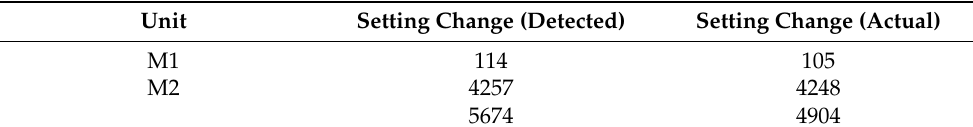
Table 7. Performances of the clustering-based from scratch approach (extruder).